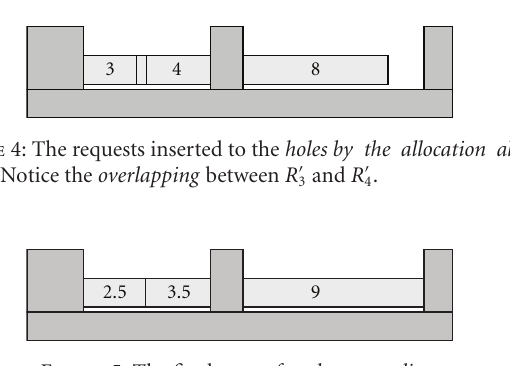
Figure 5: The final state after the postscaling .